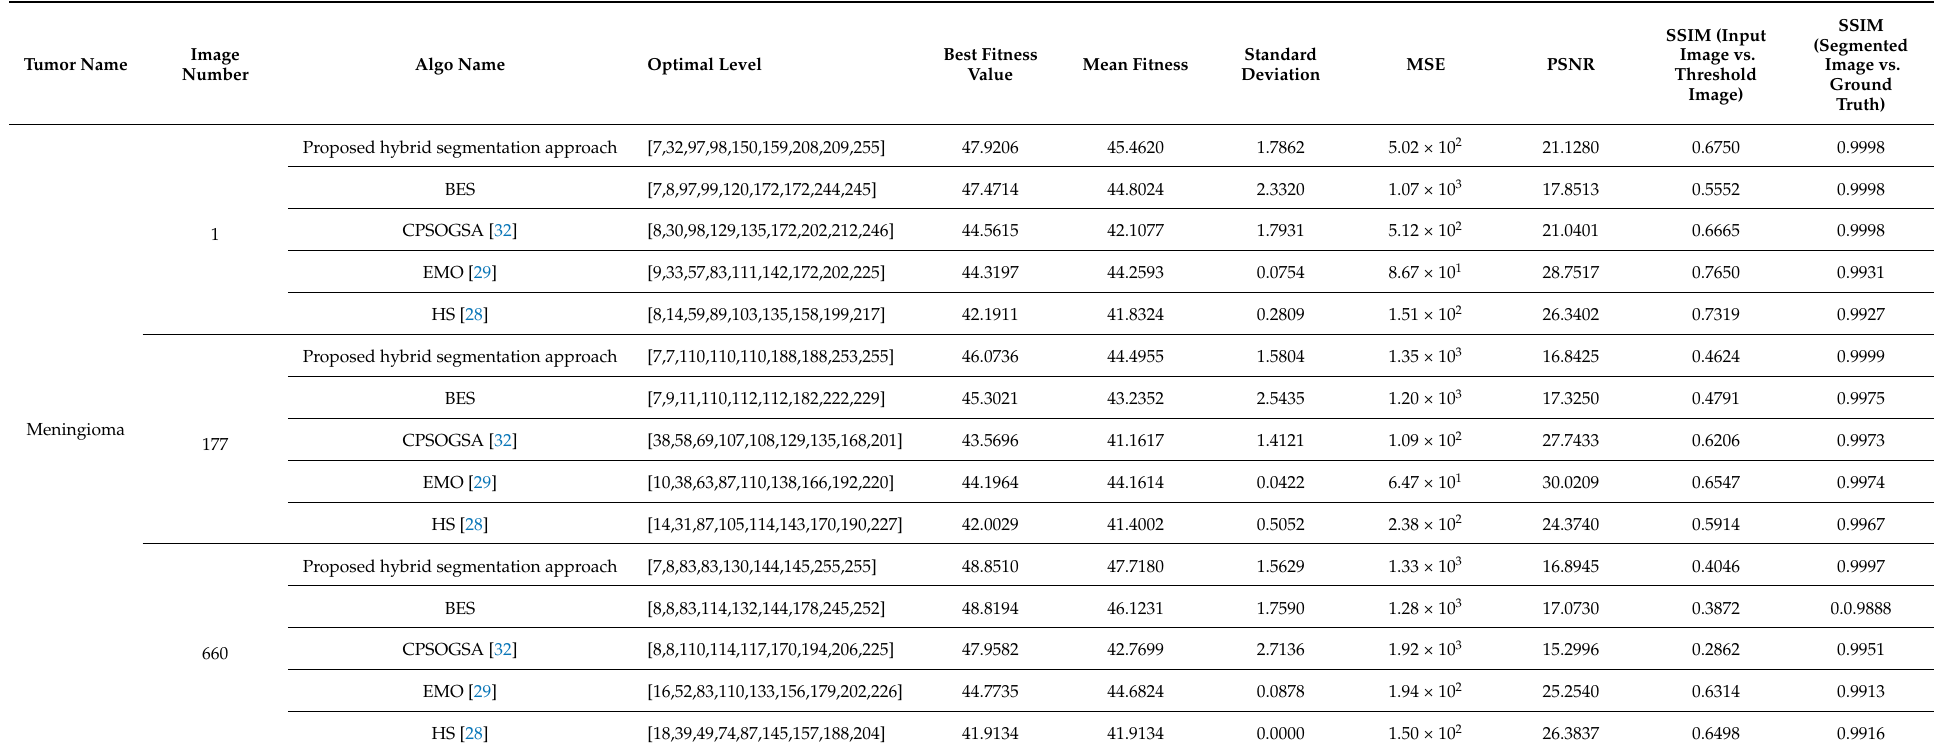
Table 2. Evaluation metrics of the proposed hybrid segmentation